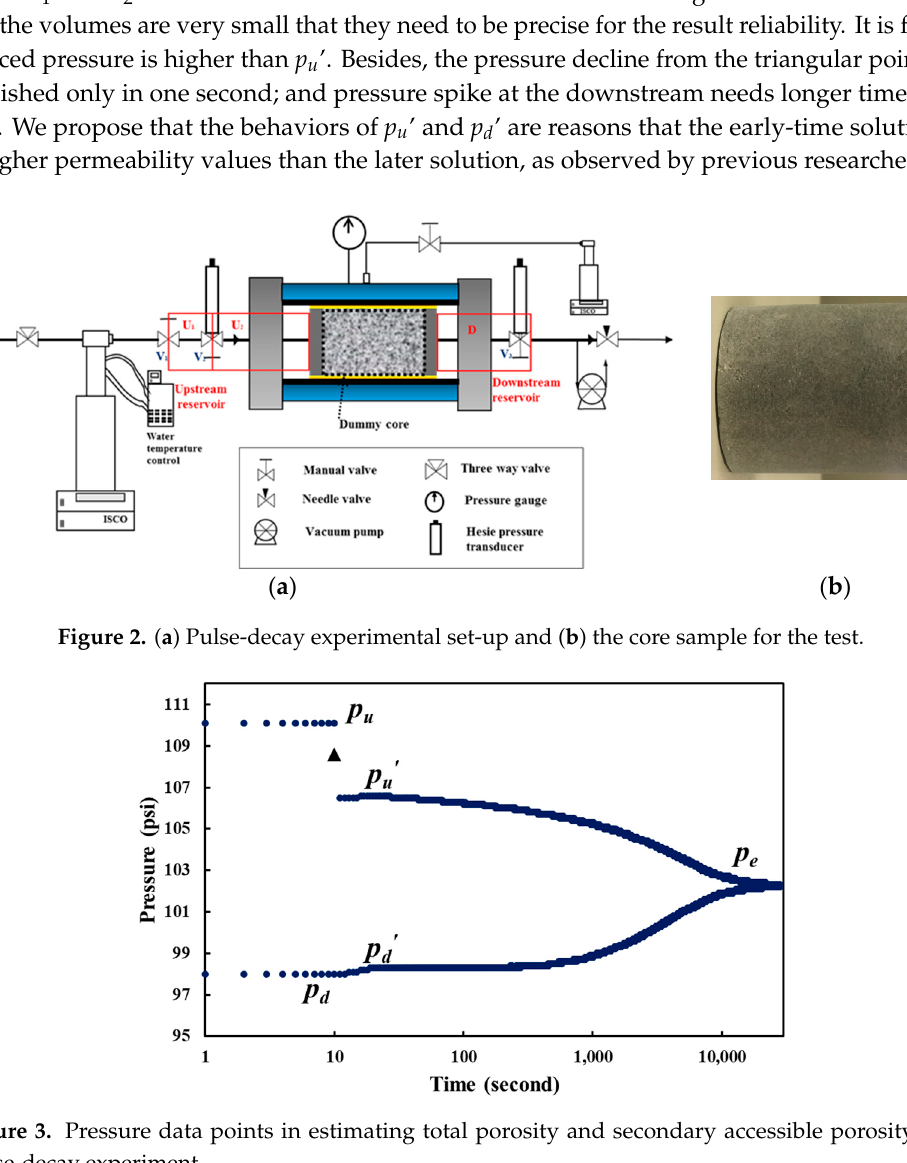
Figure 2. ( a ) Pulse-decay experimental set-up and ( b ) the core sample for the test.